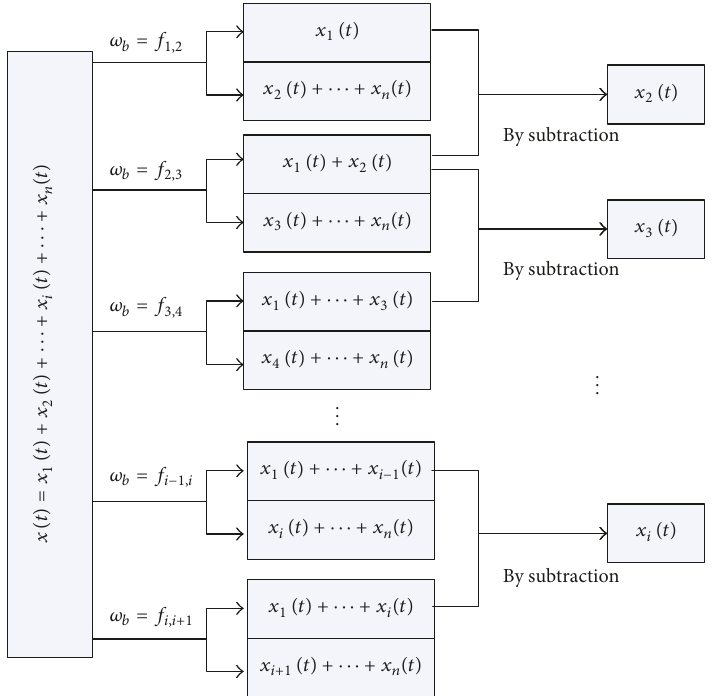
Figure 3: The schematic diagram of the extracted signal by AMD